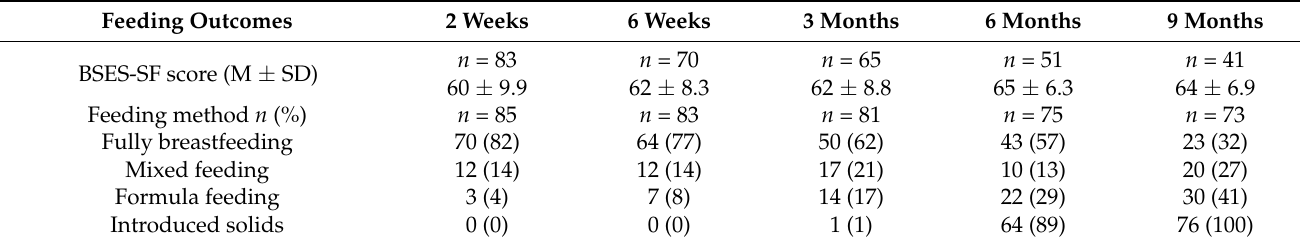
Table 2. Feeding outcomes across the first nine months.